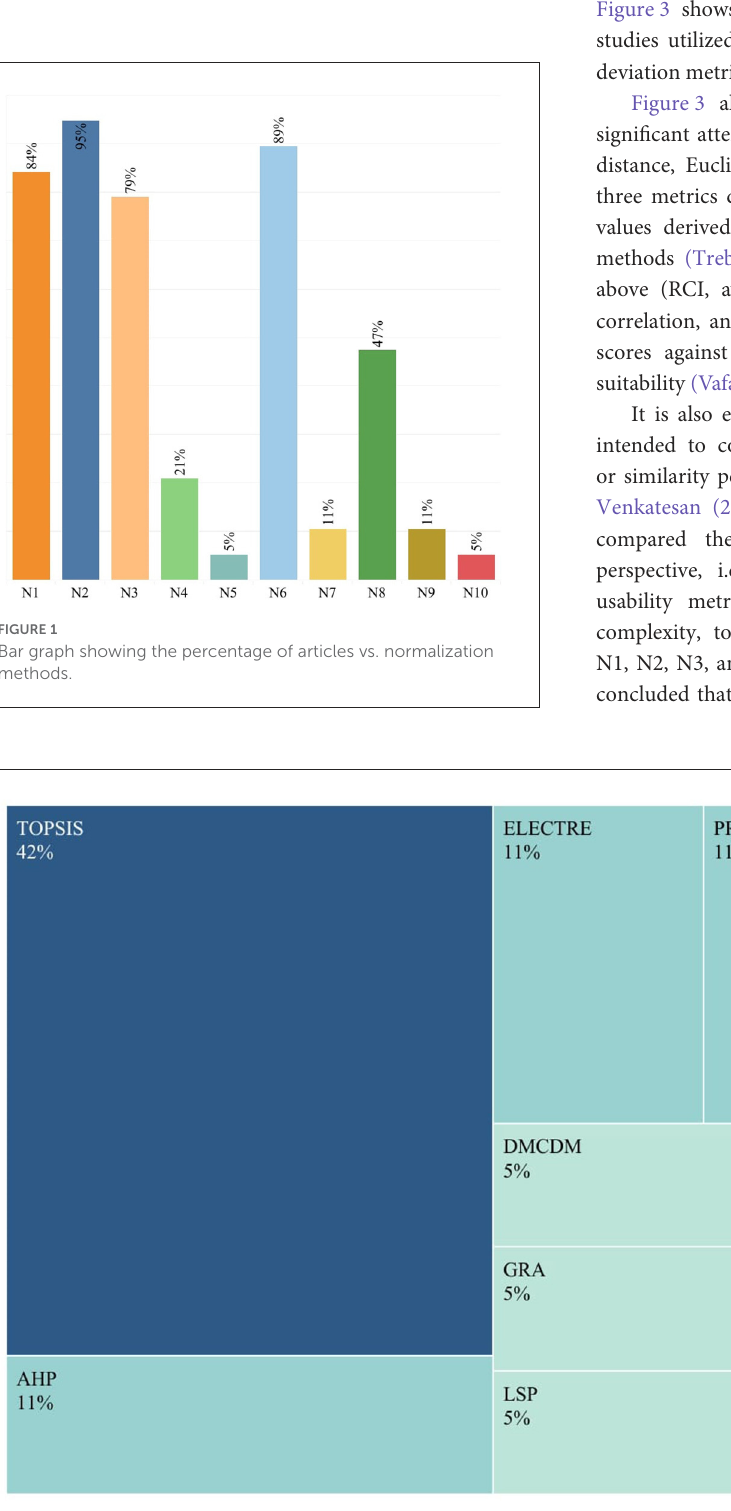
FIGURE2 Treemap showing the percentage of articles vs. MCDM